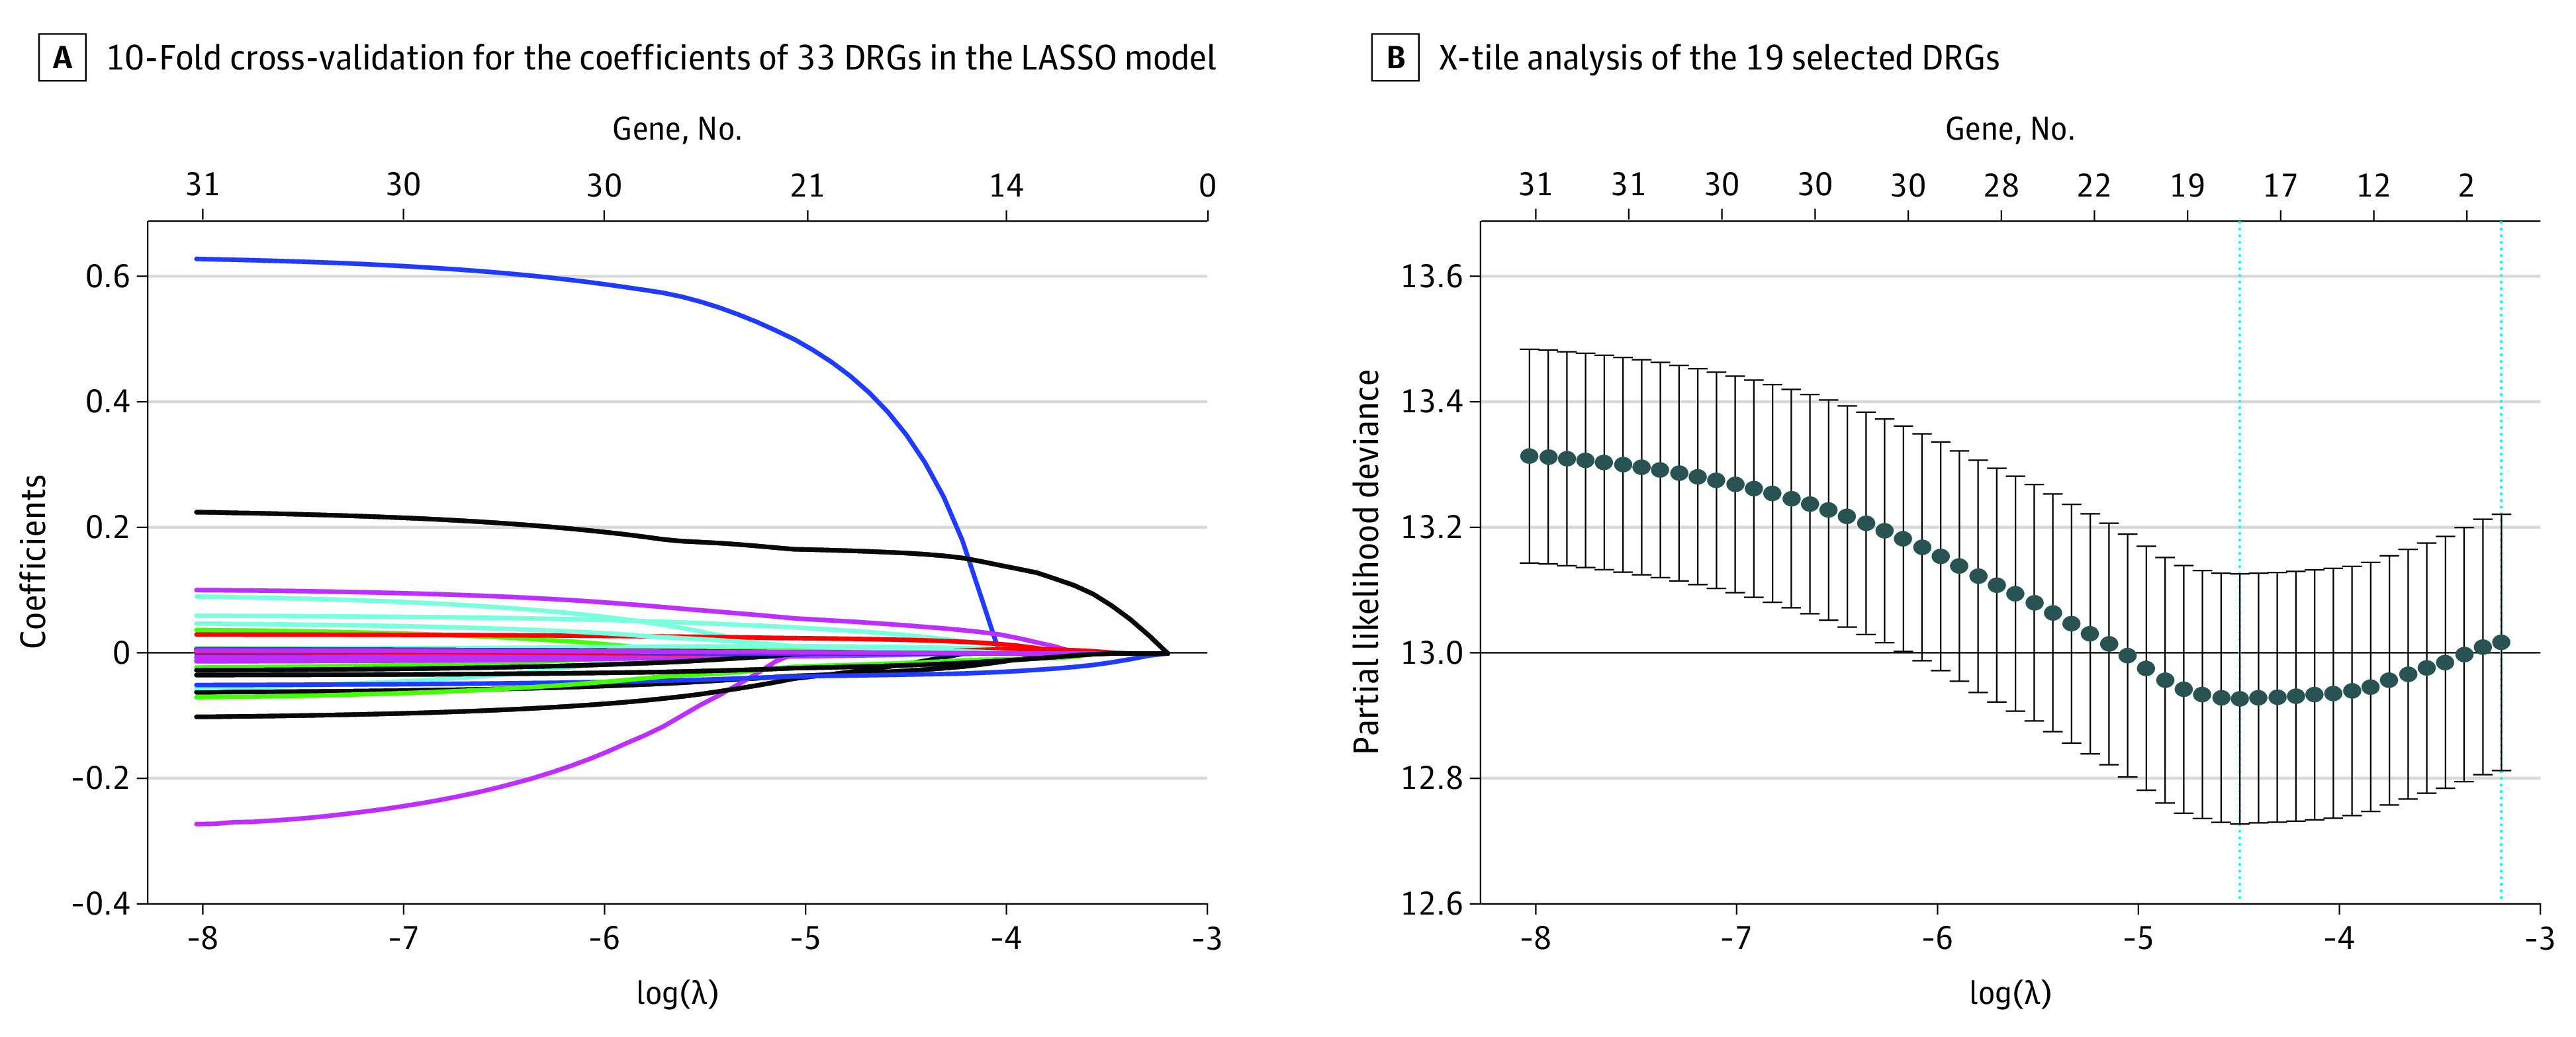
Selection of DNA Repair–Related Genes (DRGs) Using the Least Absolute Shrinkage and Selection Operator (LASSO) ModelError bars indicate 95% CIs.